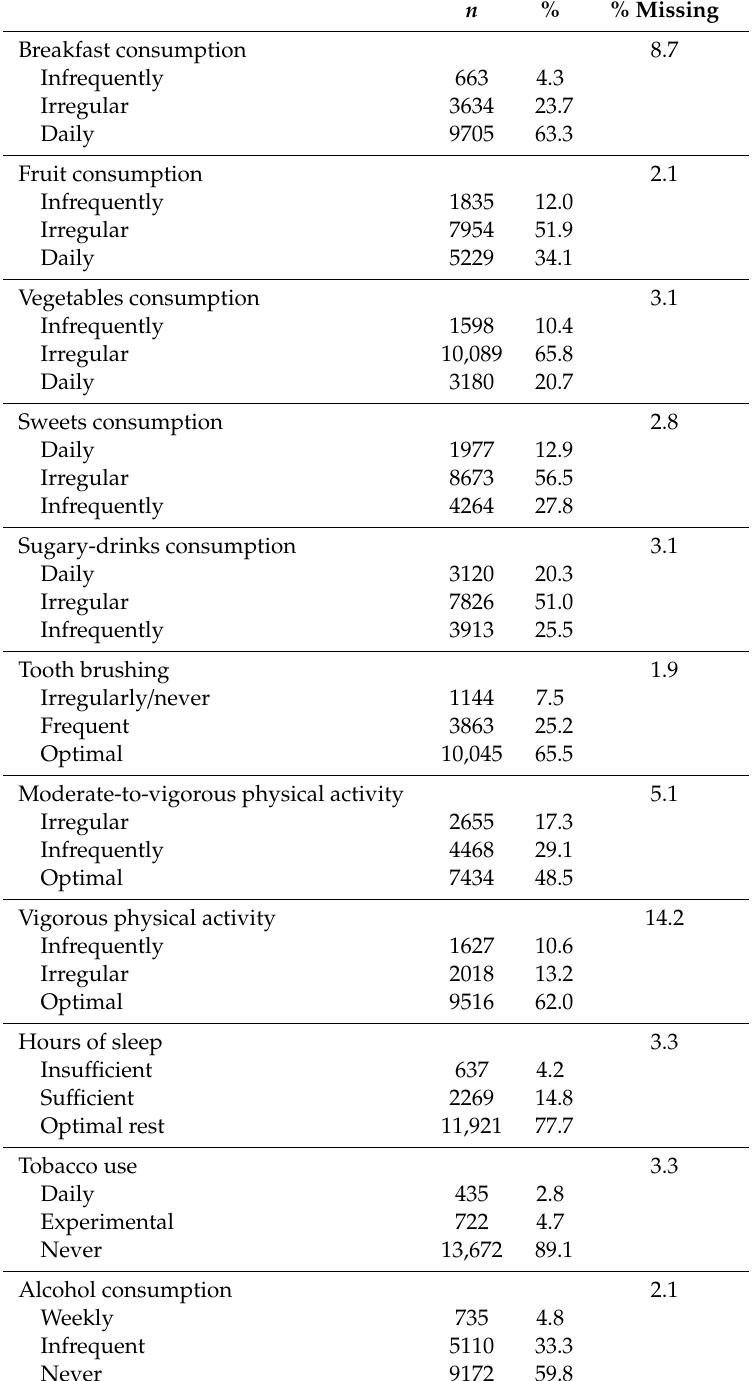
Table 3. Descriptive characteristics of the sample population ( n = 15,340) in all health behaviors used to calculate the global health